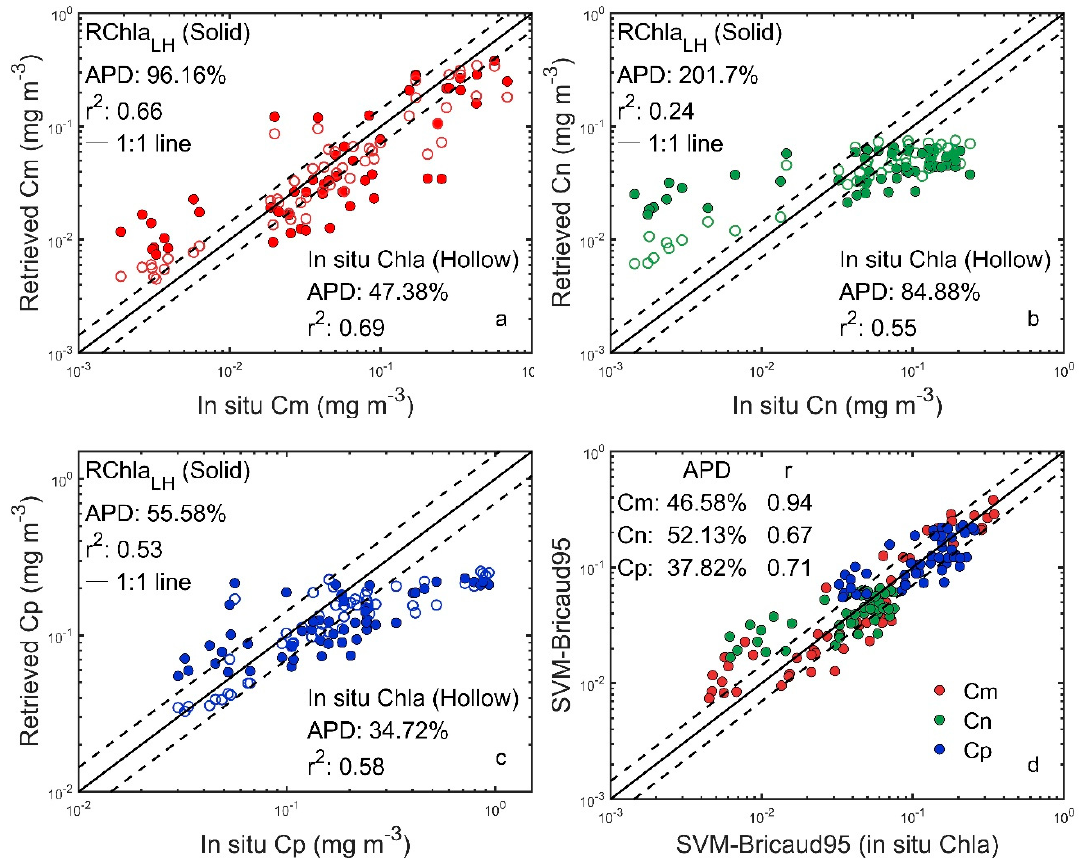
Figure 11. Scatter plots of PSC retrieved using SVM-Bricaud95 and SVM-Bricaud95 (in situ Chla) for ( a ) Cm, ( b ) Cn, and ( c ) Cp. Scatter plots of SVM-Bricaud95 and SVM-Bricaud95 (in situ Chla) (open circle) versus (solid circle) ( d ). The black line represents the 1:1 line and the dotted lines represent the 1:1 line ± 30% log 10 PSC.